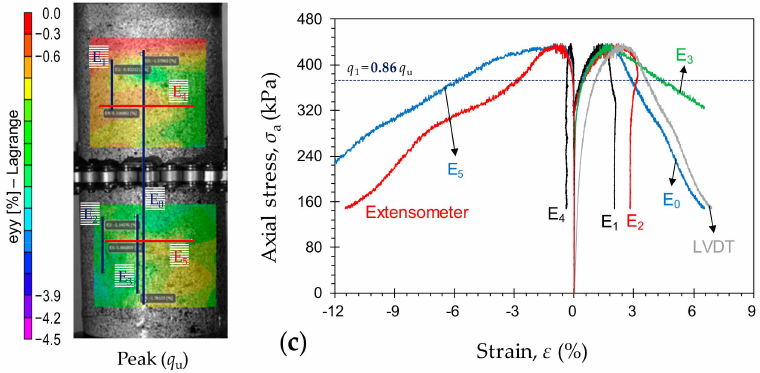
Figure 9. Typical stress–strain curves, obtained by means of various measurement techniques, for the tested samples: ( a ) P 4 F 0 T 14 ; ( b ) P 4 F 0 T 28 ; and ( c ) P 4 F 0 T 56